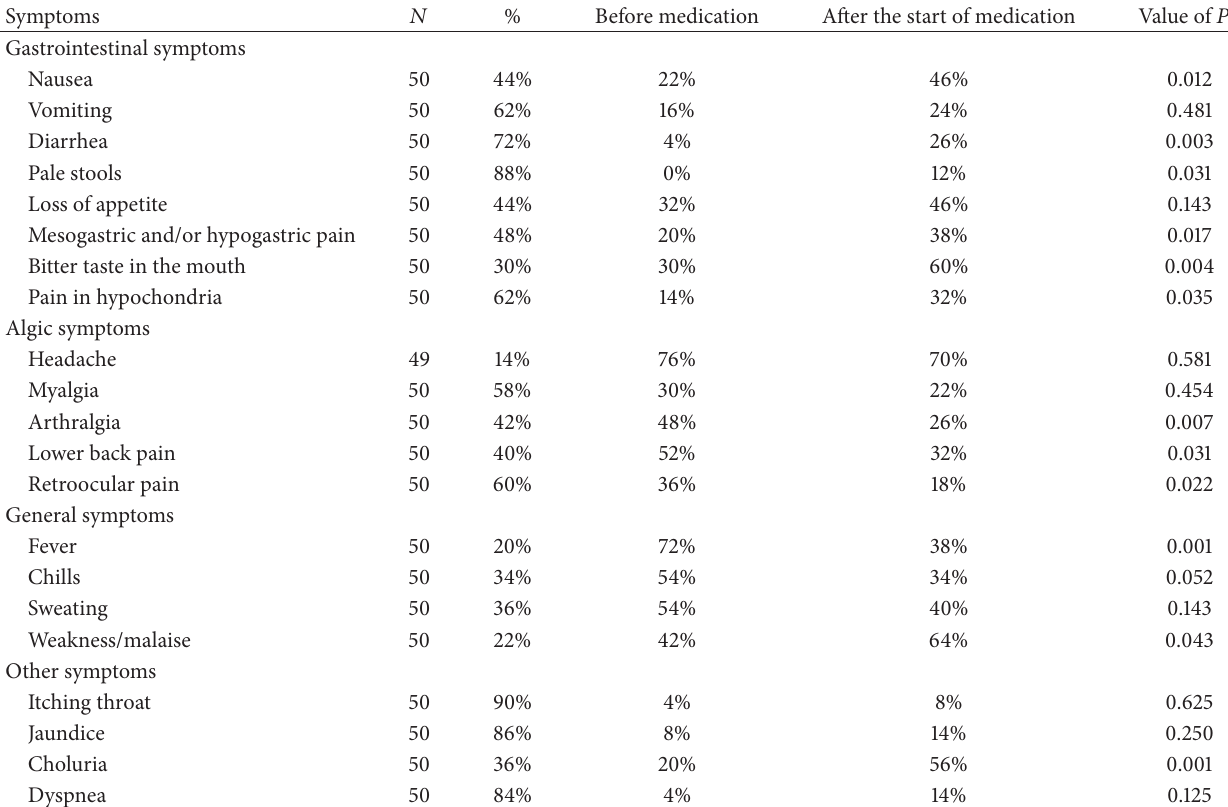
Table 2: Malaria symptoms occurring before and after drug treatment.